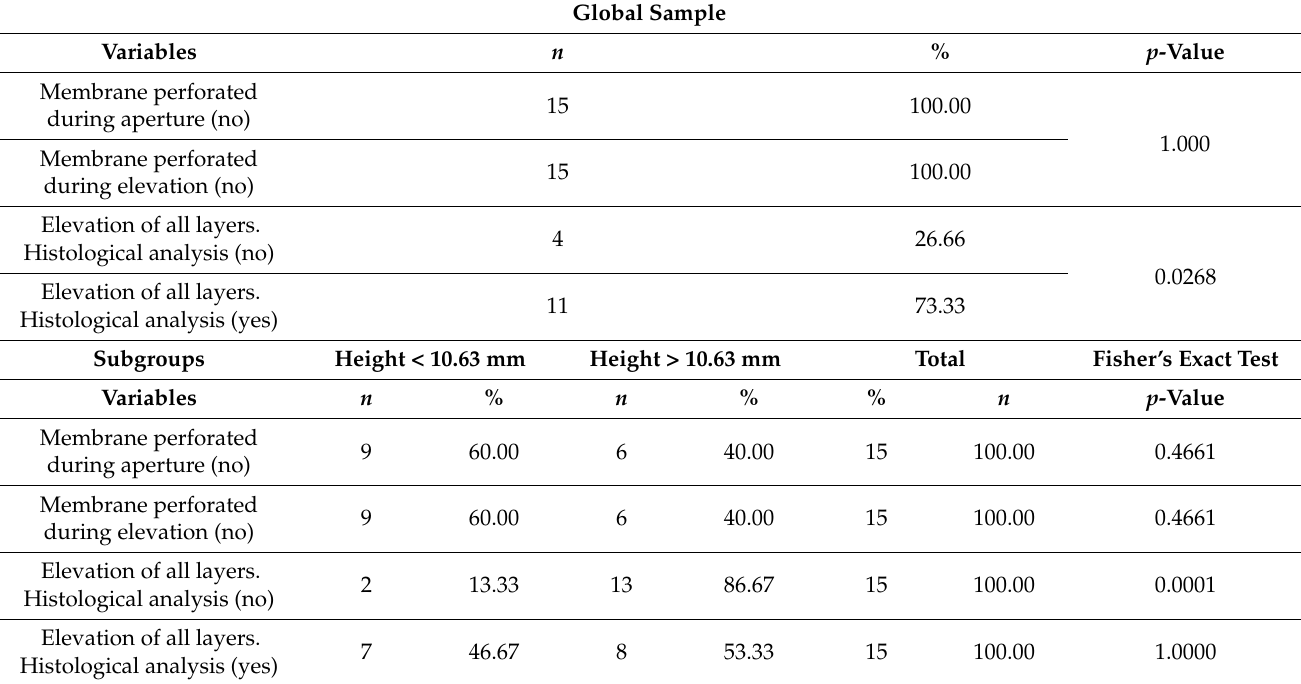
Table 3. Distribution and comparison of membrane perforation and histology within groups for maxillary membrane height and global sample.